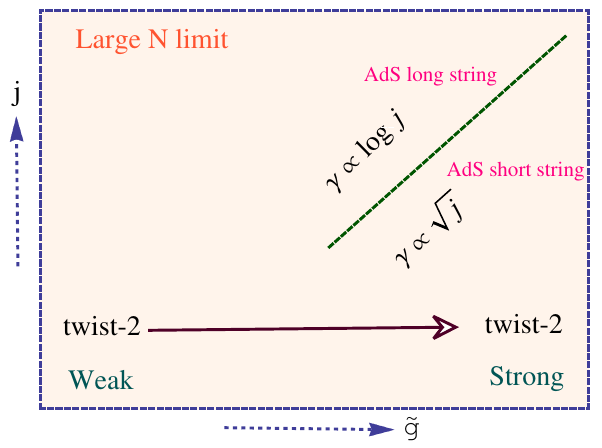
Figure 5. The transition between di(cid:11)erent j dependence for twist-two anomalous dimensions in the large N